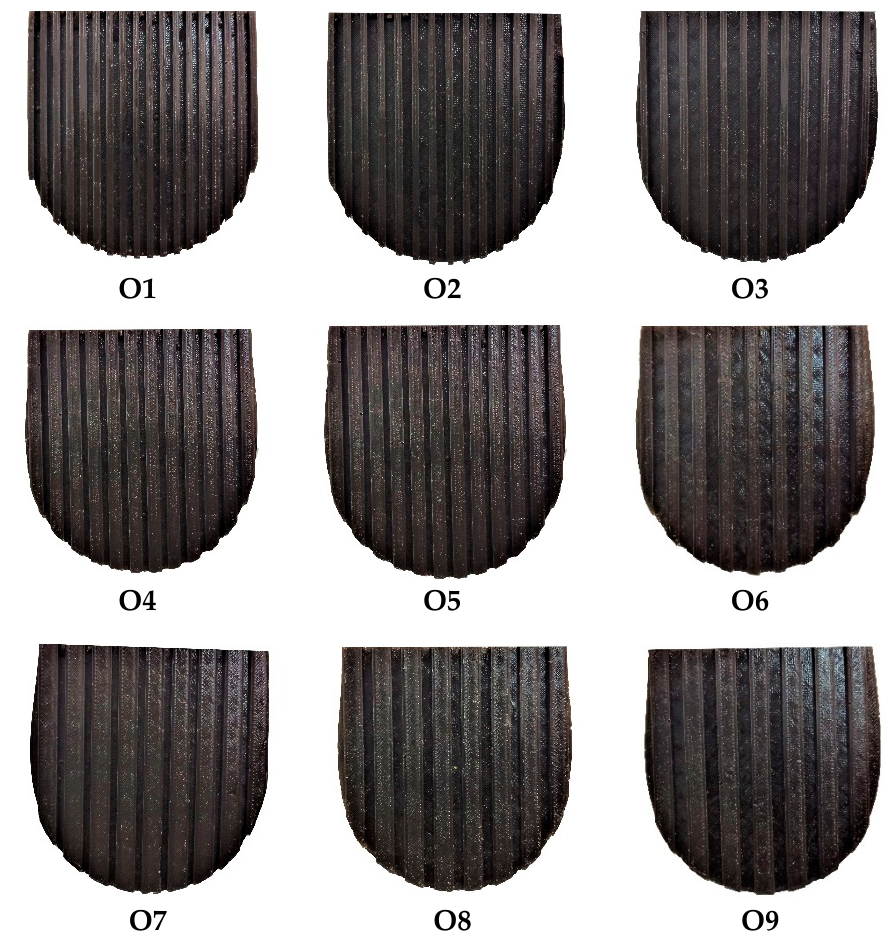
equation for the conservation of mass (2) were pre-programmed for the simulations.